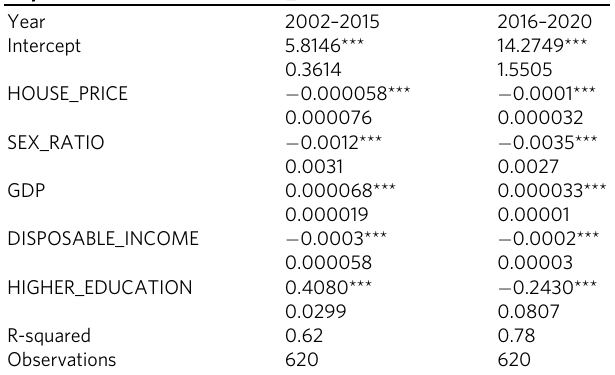
Table 4 Regression results before and after the two-child